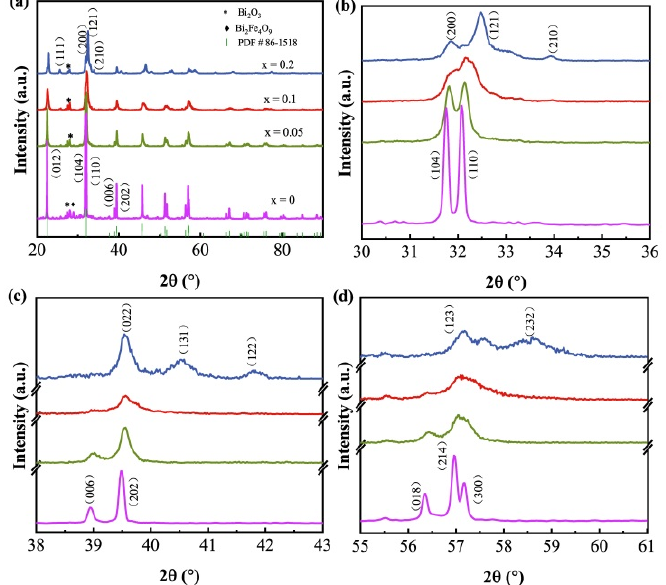
Figure 1. ( a ) XRD patterns of Bi 1 − x Er x FeO 3 nanoparticles, and the enlarged diffraction peaks ( b ) around 32 ◦ , ( c ) ranging from 38 ◦ to 43 ◦ , ( d ) ranging from 55 ◦ to 61 ◦